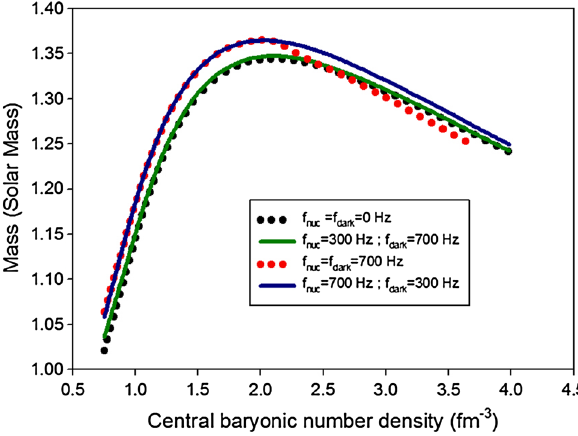
Fig. 8 Plots of total mass vs. central dark matter density of static, rigidly rotating and differentially rotating neutron stars mixed with self- interacting fermionic asymmetric dark matter with fixed nuclear matter central enthalpy (0 . 24 c 2 ) and varying dark matter central